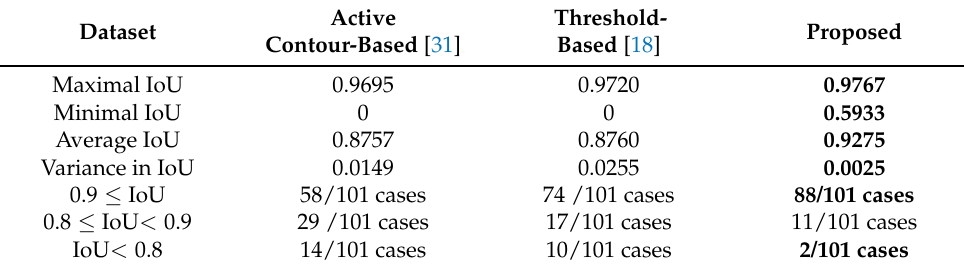
Table 7. Comparison of results in the DRISHTI-GS dataset with reproduced algorithms with